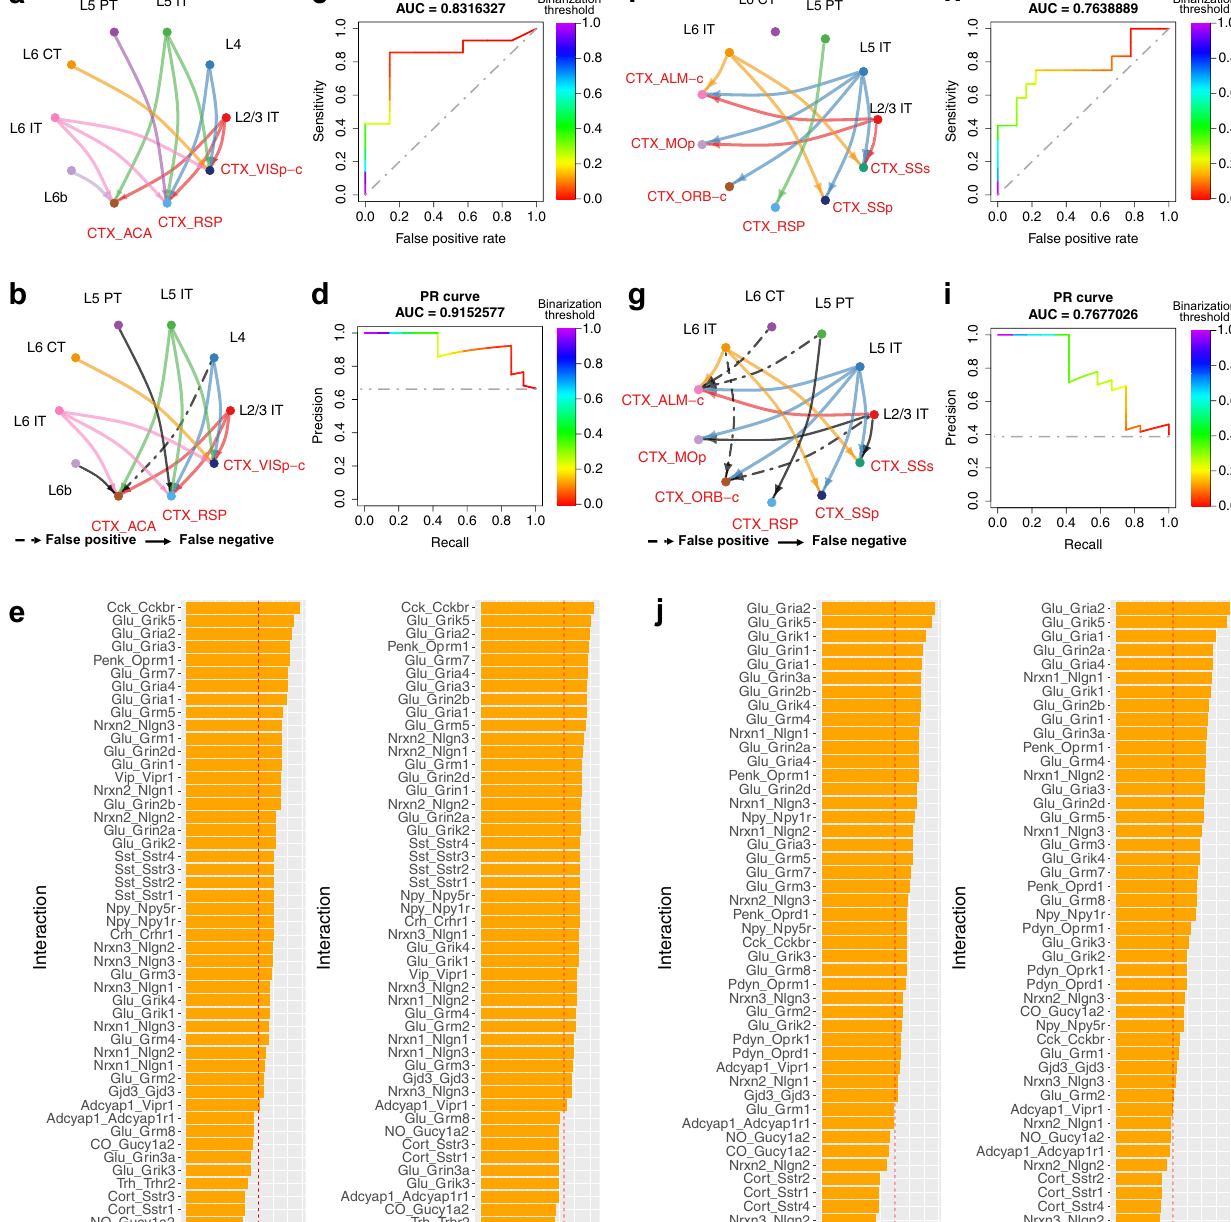
The gray dashed line represents the random classi fi er with an AUROC of 0.5. The color bar indicates the binarization threshold. d PR curve for NeuonChat-inferred aggregated intercellular communication network for VISp, with AUPRC indicated on the top. The gray dashed line represents the random classi fi er with an AUPRC equaltothefractionof links identi fi edbyretrograde labeling(i.e.,14/21). e AUROC (left panel) and AUPRC (right panel) for the inferred VISp projection network of each individual interaction pair. f – j Repeat analysis for ALM, analogous to ( a – e ). Threshold for binarization is 0.165 for ( g